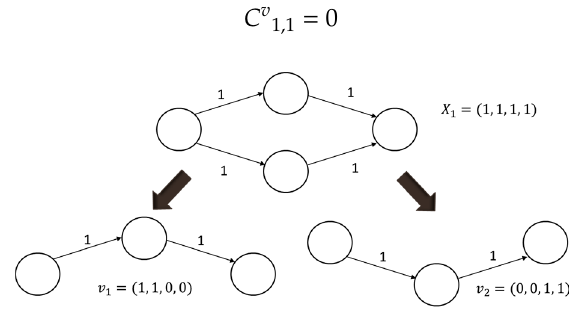
Figure 4. X 1 Path solution.